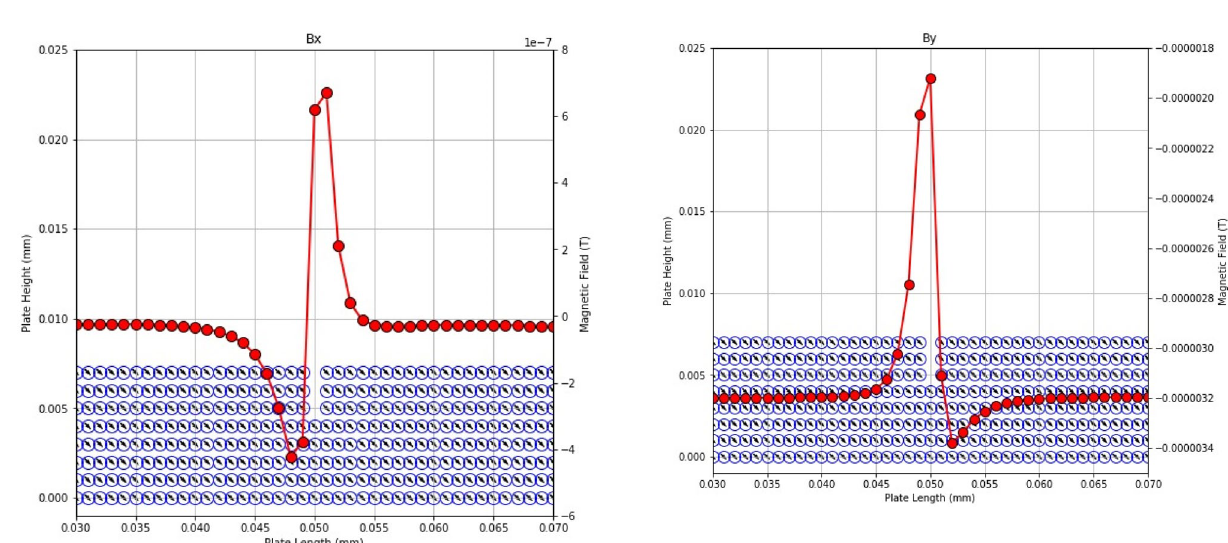
Fig. 9 Magnetic field Y of a rectangular defect with ordered mag- netic